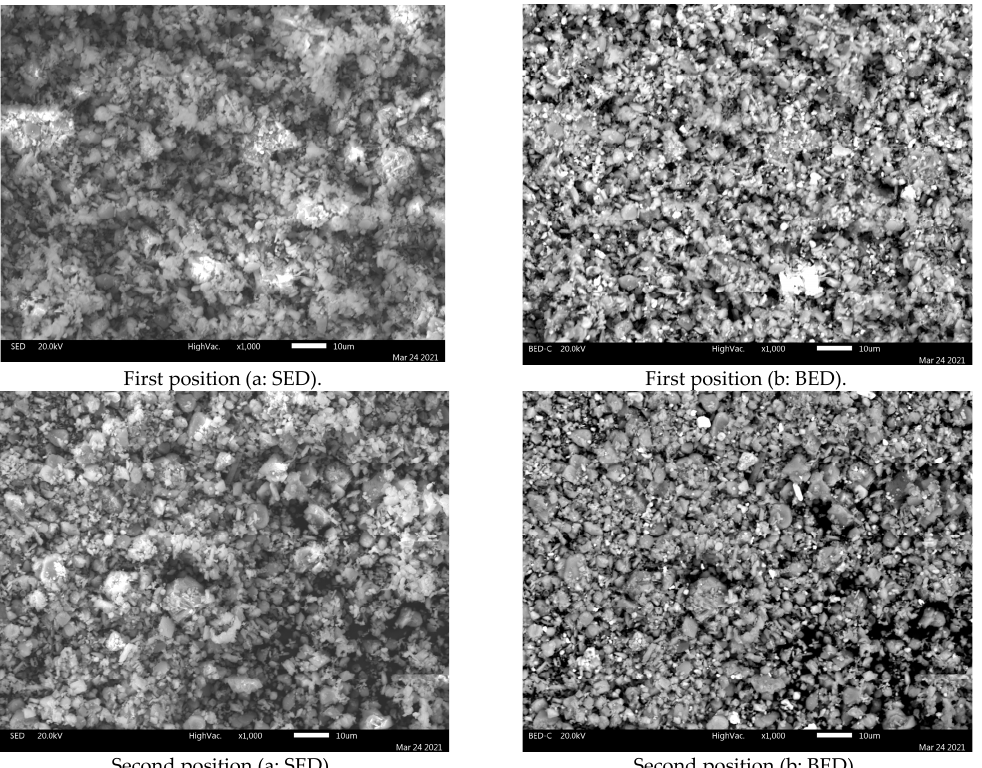
Figure 4. SEM (a: SED; b: BED) images of the jarosite sample recorded at 1000× magni fi cation at two di ff erent positions.